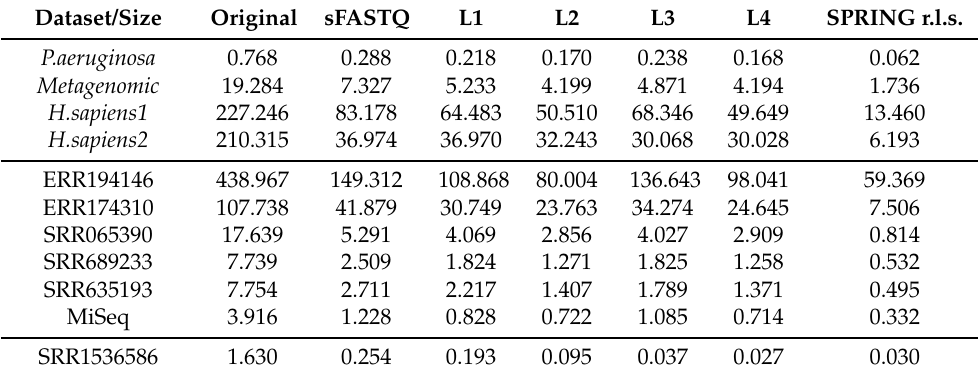
Table 2. Results for four different types of lossy compression of selected datasets. The datasets in the first two parts of the Table are the same as in Table 1, and the dataset in the third part contains single end sequenced transcriptomic data from [15]. Sizes of datasets are expressed in gigabytes (10 9 bytes). SPRING r.l.s. means SPRING recommended lossy size.